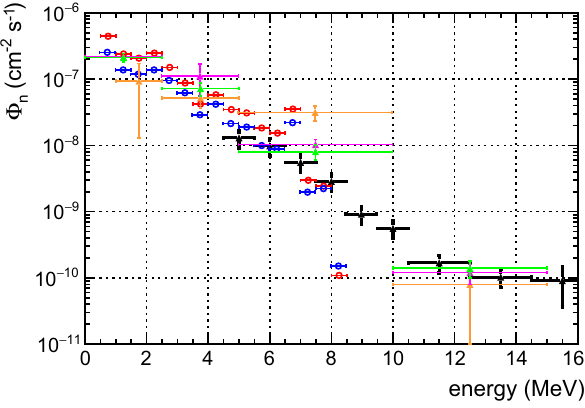
Fig. 8 Intrinsic efficiency (cid:6) int as a function of the neutron energy tank has been identified as the major contributor to neutron moderation. Therefore to study the attenuation due to the GERDA watertank an additional simulation has been run using a spherical surface of radius equal to 22 m which is big enough to contain it entirely. Its contribution corresponds to a reduction of the geometrical efficiency, defined hereafter in text, by 30%.